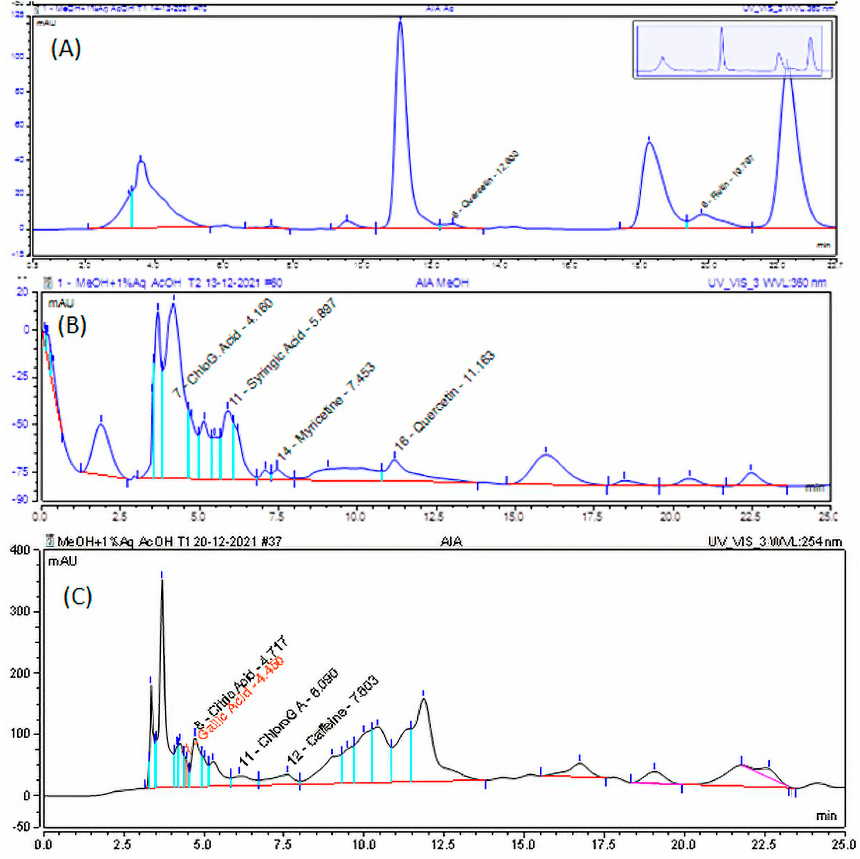
Figure 2. HPLC chromatograms for ( A ) acetone, ( B ) methanol, and ( C ) 75% methanol extract of the aerial part of A. integrifolia. Table 3. HPLC quantitative result for A. integrifolia